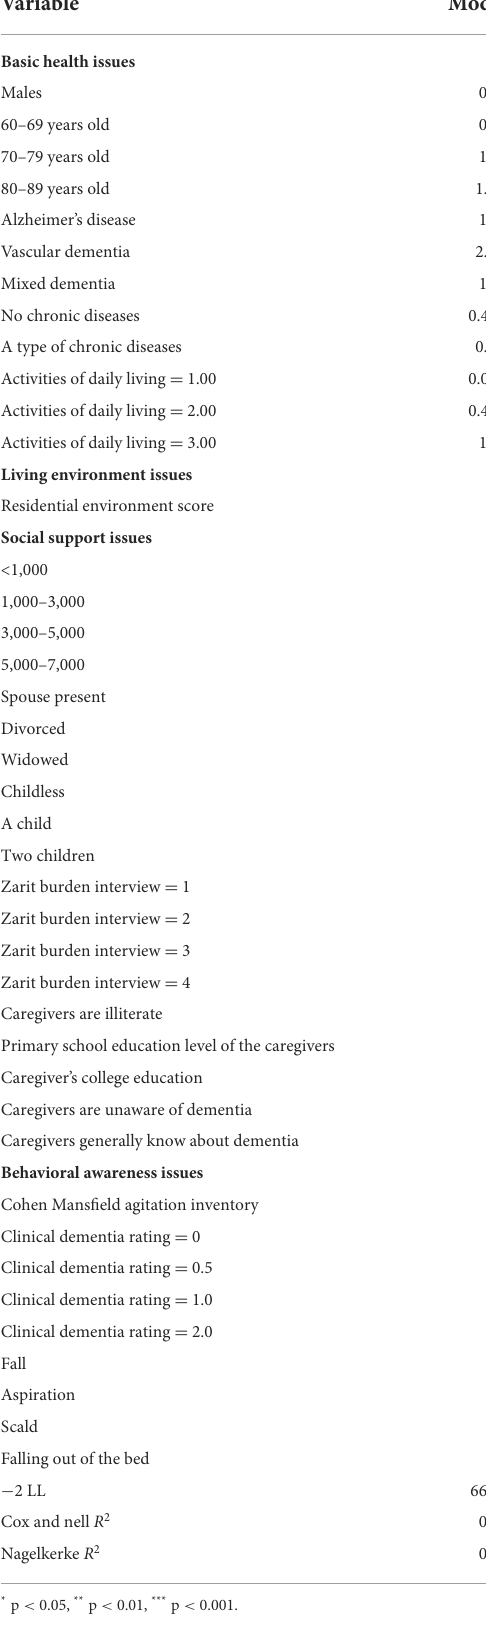
TABLE 3 Multiple orderly regression of the risk factors associated with falls (OR). Variable Model one Model two Model three Model